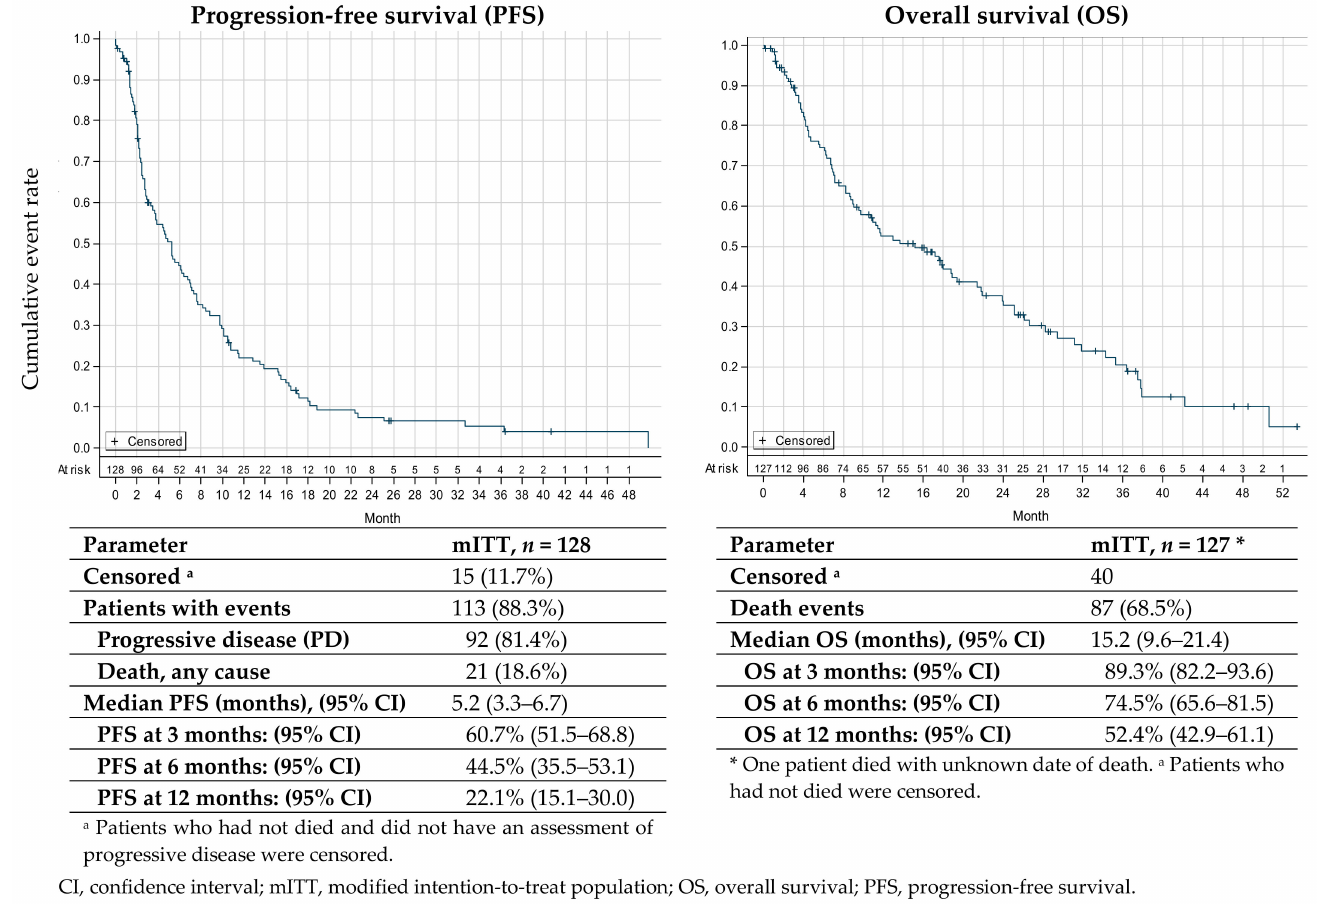
Figure 2. Kaplan–Meier plot of progression-free survival and overall